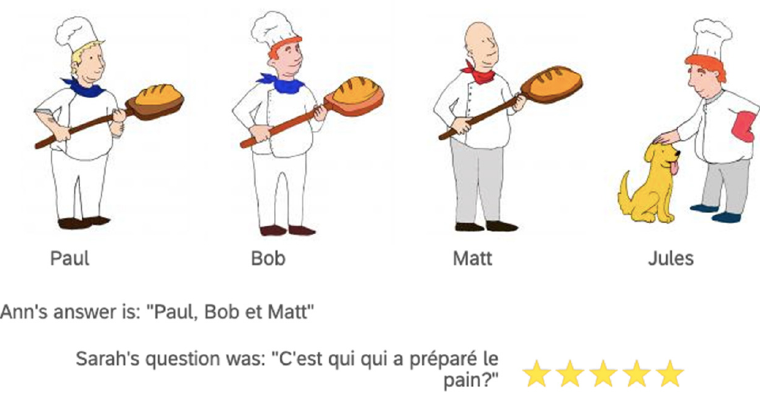
Figure 2. Sample test item, including the picture, Ann’s answer and Sarah’s question, to be rated.